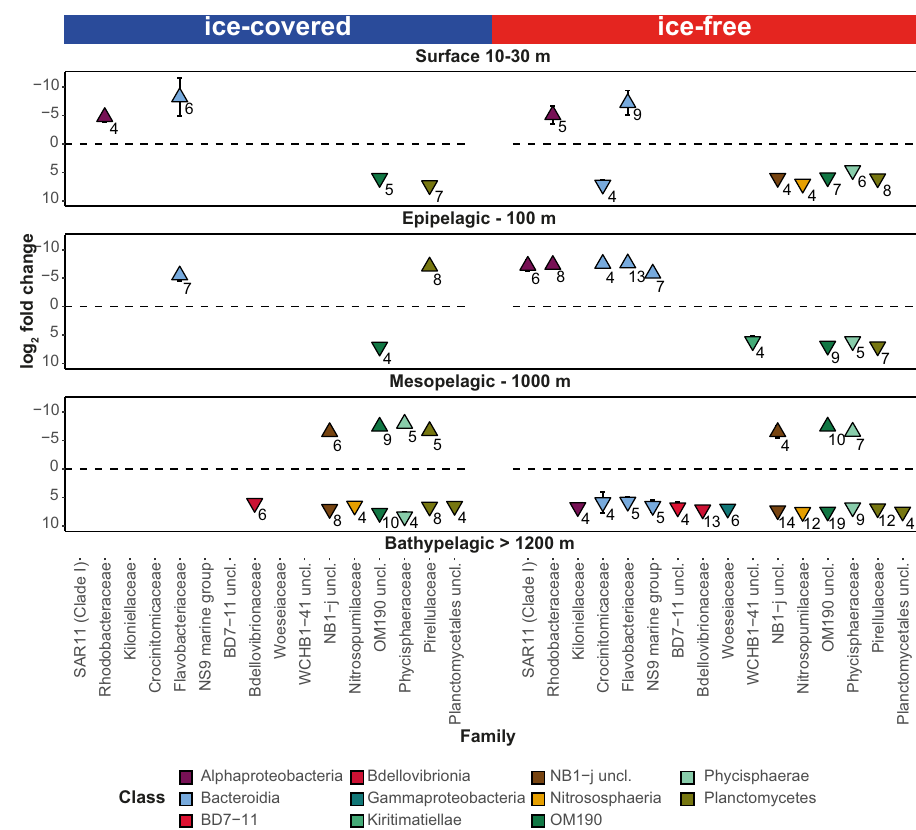
Fig. 5 Differences in particle-associated (PA) community composition between the distinct water layers, in ice-covered and ice-free regions. Enriched taxonomic families between each two consecutive depths (surface-epipelagic, epipelagic-mesopelagic and mesopelagic-bathypelagic), ordered according to labels between the panels. The y -axis represents the mean log 2 fold-change for microbial families with more than 3 ASVs with log 2 fold-change absolute value higher than 1 (standard error is smaller than the point). Positive value represent enrichment in deeper water layers and negative value represents enrichment in shallower water layer. The numbers near the symbols represent the number of ASVs enriched in the depth. The x -axis is ordered according to the different taxonomic classes, represented by the color